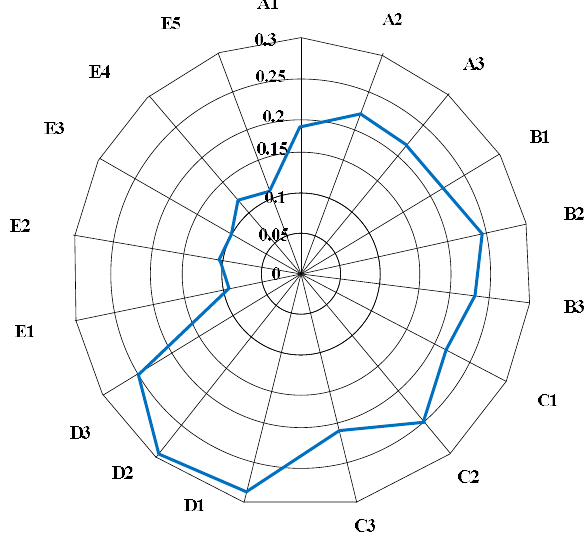
Fig. 2. Performance values of 17 criteria for case